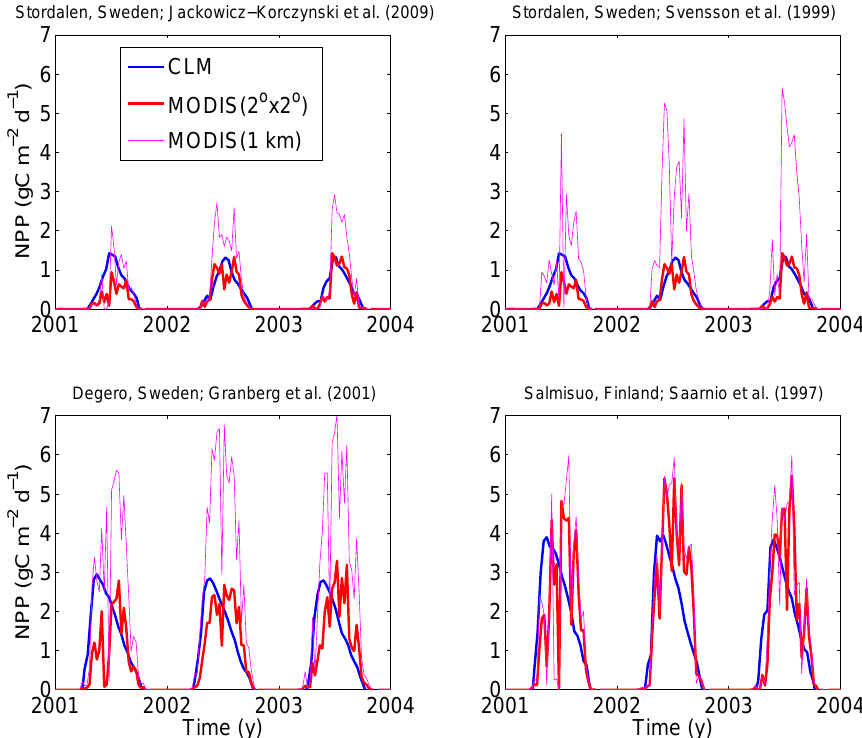
Fig. 10. NPP estimates from CLM4, 2 ◦ × 2 ◦ MODIS, and the MODIS 1km gridcell corresponding to the site.